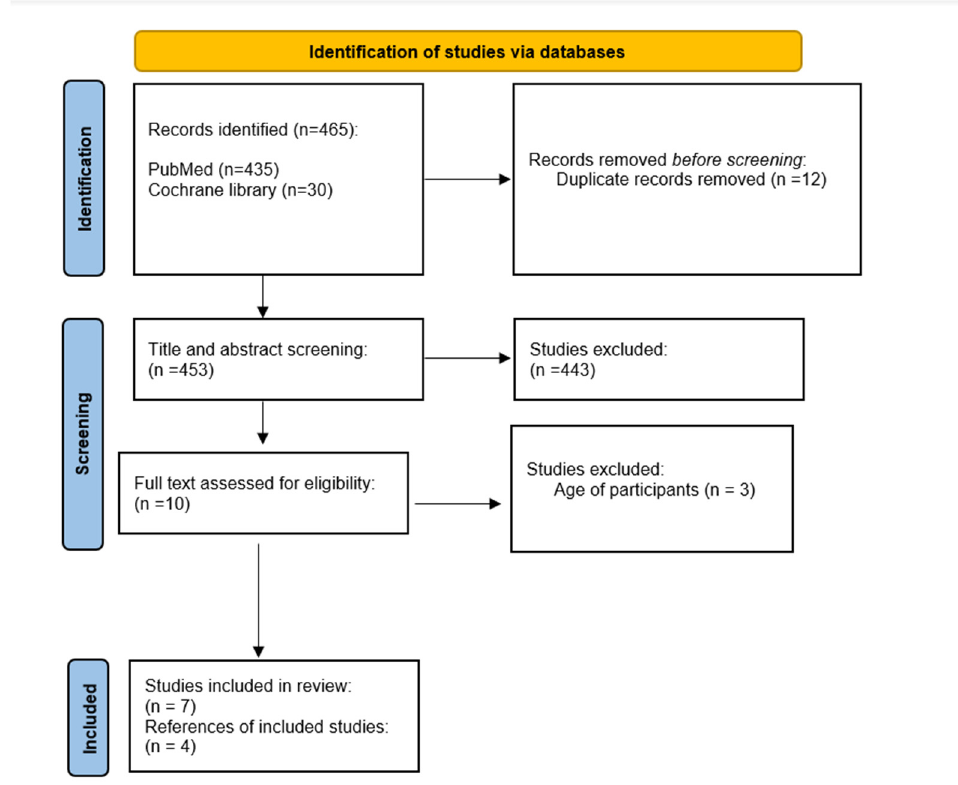
Figure 1. Prisma flow diagram.